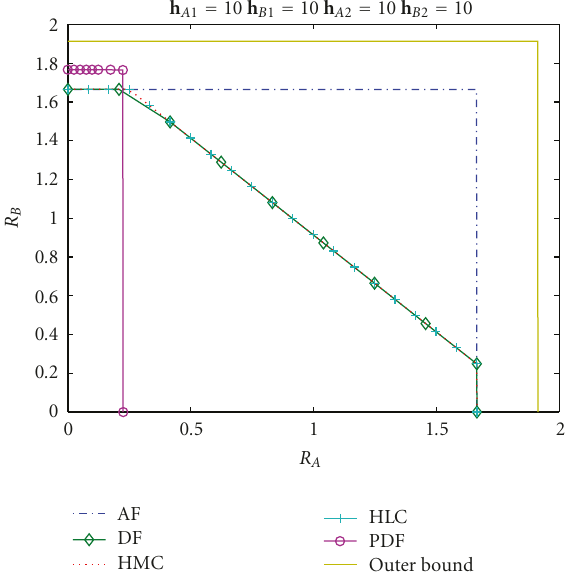
Figure 3: The achievable rate regions when all link gains are large.